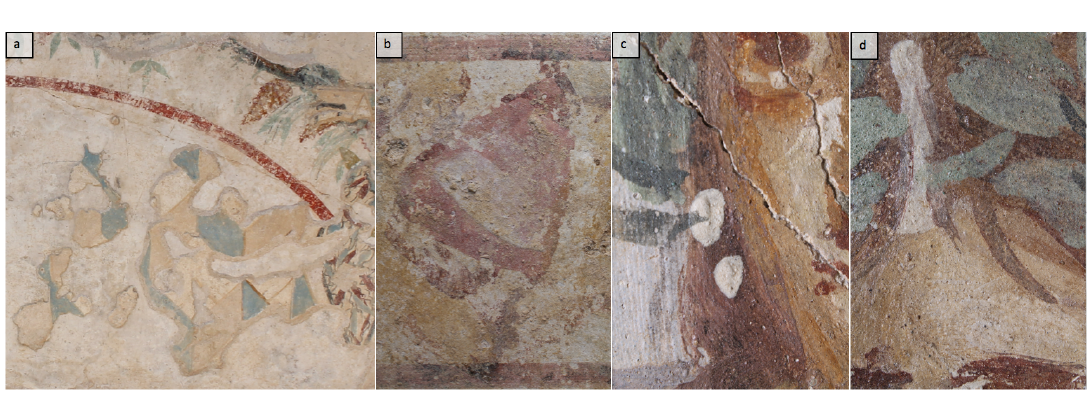
Figure 17. Details of paintings from Tomb 3882: ( a ) white geometric patterns alternating with blue geometric patterns (N1); ( b ) A brushstroke of white pigment is applied over a pink triangle (N3). From a figurative painting recovered from the House of Aion, ( c , d ) earrings and a central decorative headpiece are produced with white pigments on the figurative painting (E5).